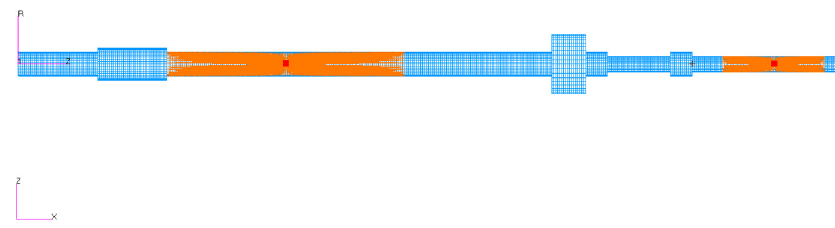
Energies 2021 , 14 , x FOR PEER REVIEW 8 of 21 Figure 7. Elements that simulate the rotor of the electric motor and compressor.